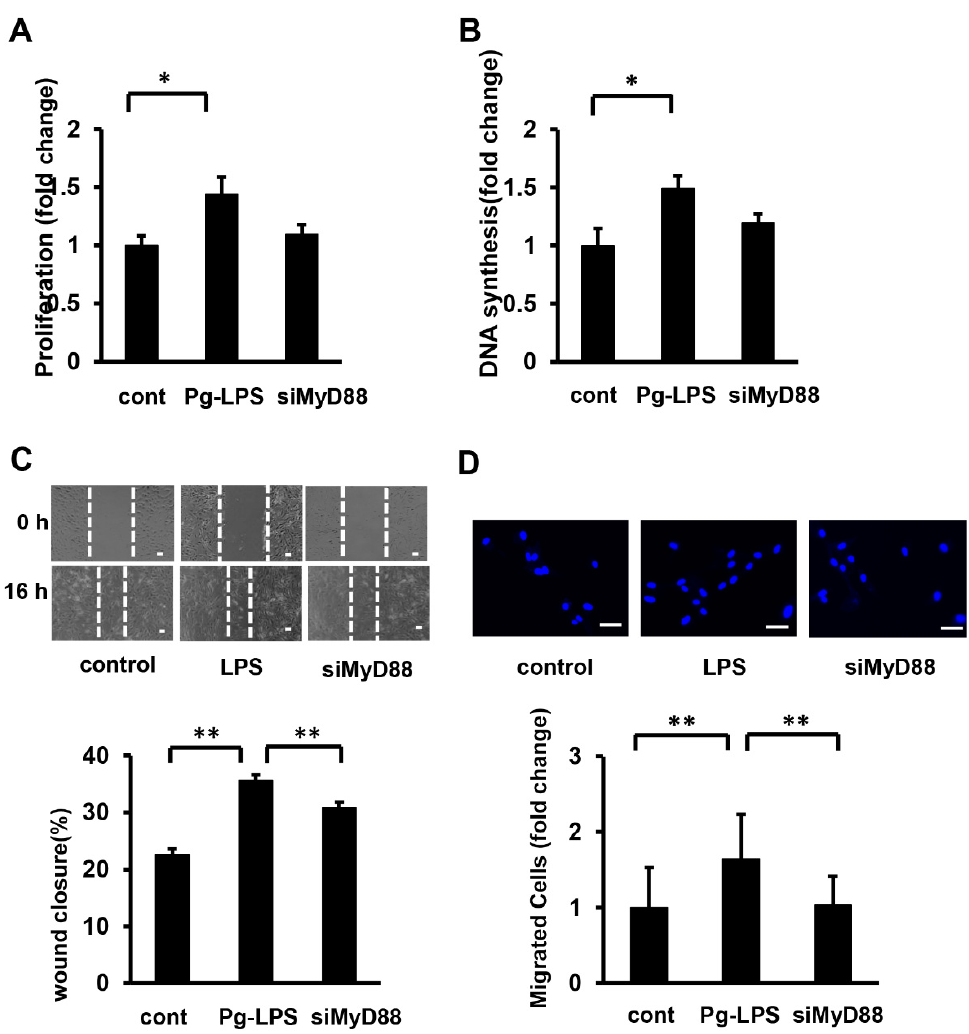
Figure 4. MyD88 siRNA attenuates Pg -LPS-induced migration of HASMCs. ( A ) The effect of MyD88 siRNA on cell number in Pg-LPS-stimulated HASMCs. MyD88 in HASMCs was knocked down (siRNA at 5 nM), stimulated with Pg -LPS (100 ng/mL) for 16 h, and evaluated using the MTT assay. n = 7 in each group. ( B ) Effect of MyD88 siRNA on DNA synthesis in Pg -LPS stimulation of HASMCs. MyD88 in HASMCs was knocked down (siRNA at 5 nM) and stimulated with Pg -LPS (100 ng/mL) for 16 h. Cells were labelled with BrdU for 16 h. n = 7 in each group. ( C ) Effect of MyD88 siRNA on the migration in Pg -LPS stimulation of HASMCs. Upper panels show the representative scratch wound healing assay. Lower panel shows the quantitative analyses of wound closure rate. MyD88 in HASMCs was knocked down (siRNA at 5 nM) and directly scratched. Cells were incubated with Pg -LPS (100 ng/mL) for 16 h. n = 5 in each group. Scale bar shows 100 μ m. ( D ) Effect of MyD88 siRNA on the migratory property in Pg -LPS stimulation of HASMCs. Upper panels show the representative DAPI staining of migrated cells. MyD88 in HASMCs was knocked down (siRNA 5 nM). Cells were seeded in transwells and treated with Pg -LPS (100 ng/mL) for 16 h. n = 6 in each group. Scale bar shows 50 µ m. * p < 0.05 vs. basal; ** p < 0.01 vs. basal. Data are presented as mean ±